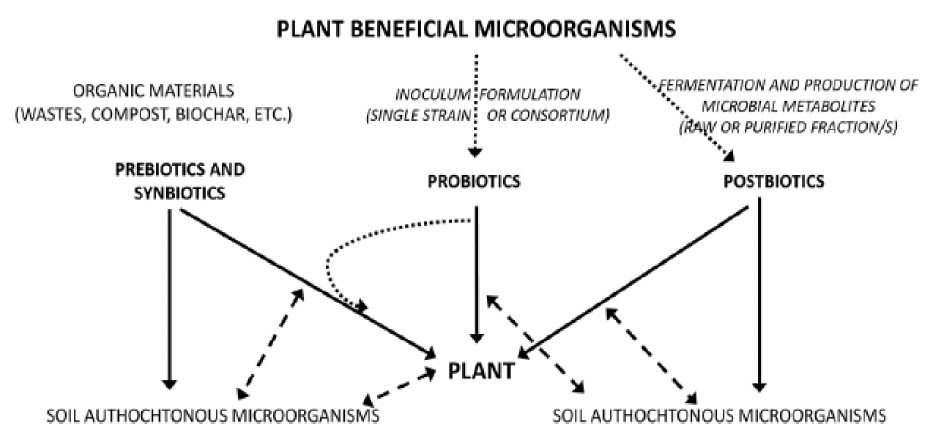
Figure 11. Diagram showing the three strategies for microbial soil–plant management based on prebiotics, probiotics, and postbiotics approaches. Legend: Full lines show the direct effect, dashed lines show the interactions, dotted lines show the formulation/production processes